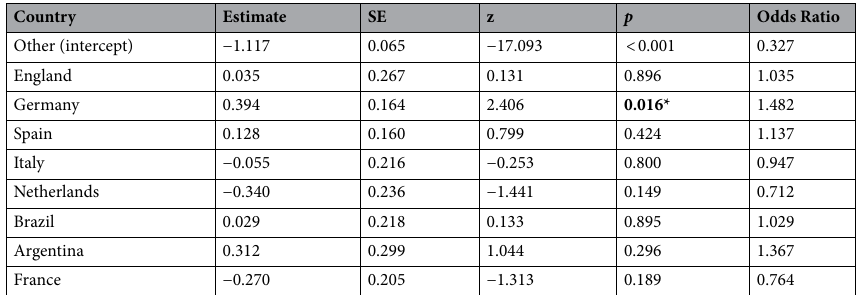
Table 5. Coefficients for the different nationalities in the binomial regression model for all penalty kicks (shootouts and in-game) faced by goalkeepers during World Cup, European Championship, Champions